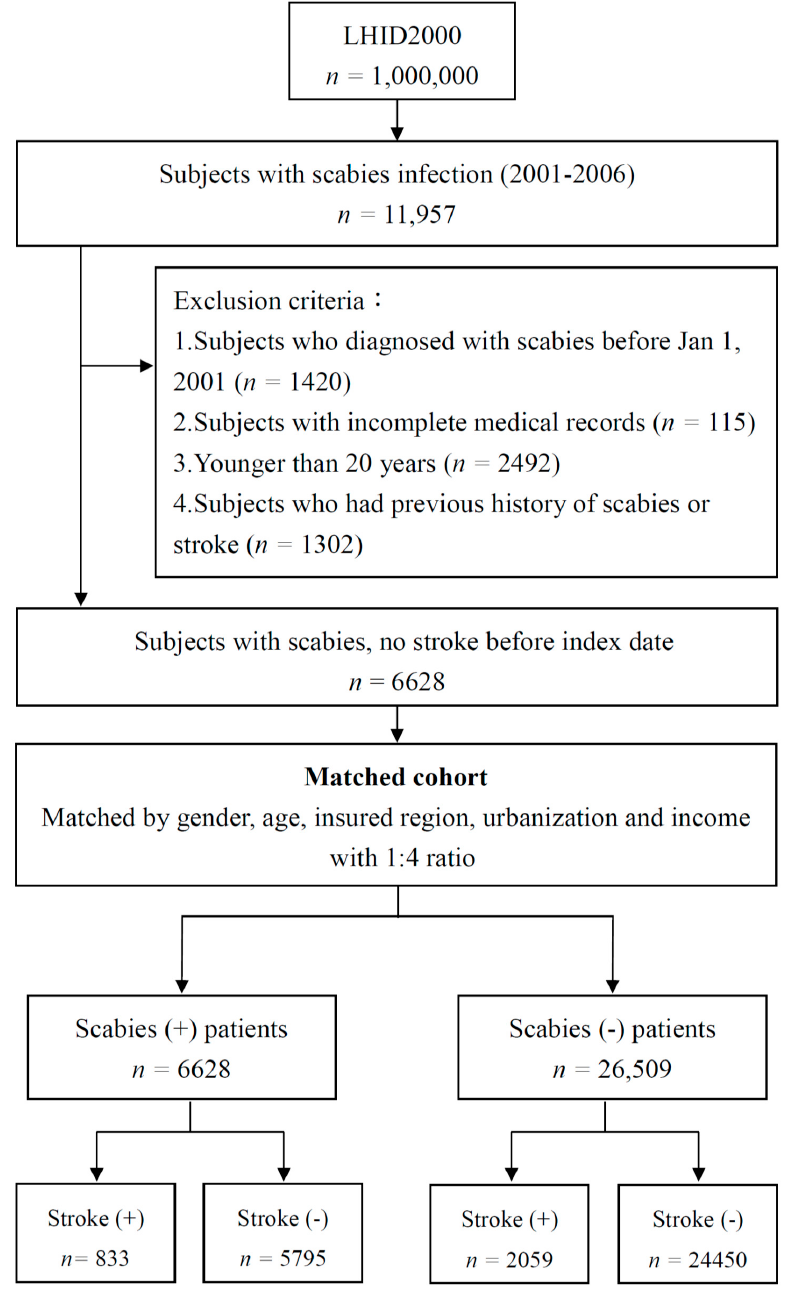
Figure 1. Flowchart of recruitment of subjects from the 1-million random sample of the National Health Insurance Research Database (NHIRD) from 2000 to 2006 in Taiwan. The exclusion criteria of the study was including: (1) Patients who were diagnosed with scabies before 1 January 2001 ( n = 1420); (2) Patients with missing medical records ( n = 115); (3) patients < 19 years old ( n = 2492); (4) patients with history of scabies or stroke ( n = 1302).